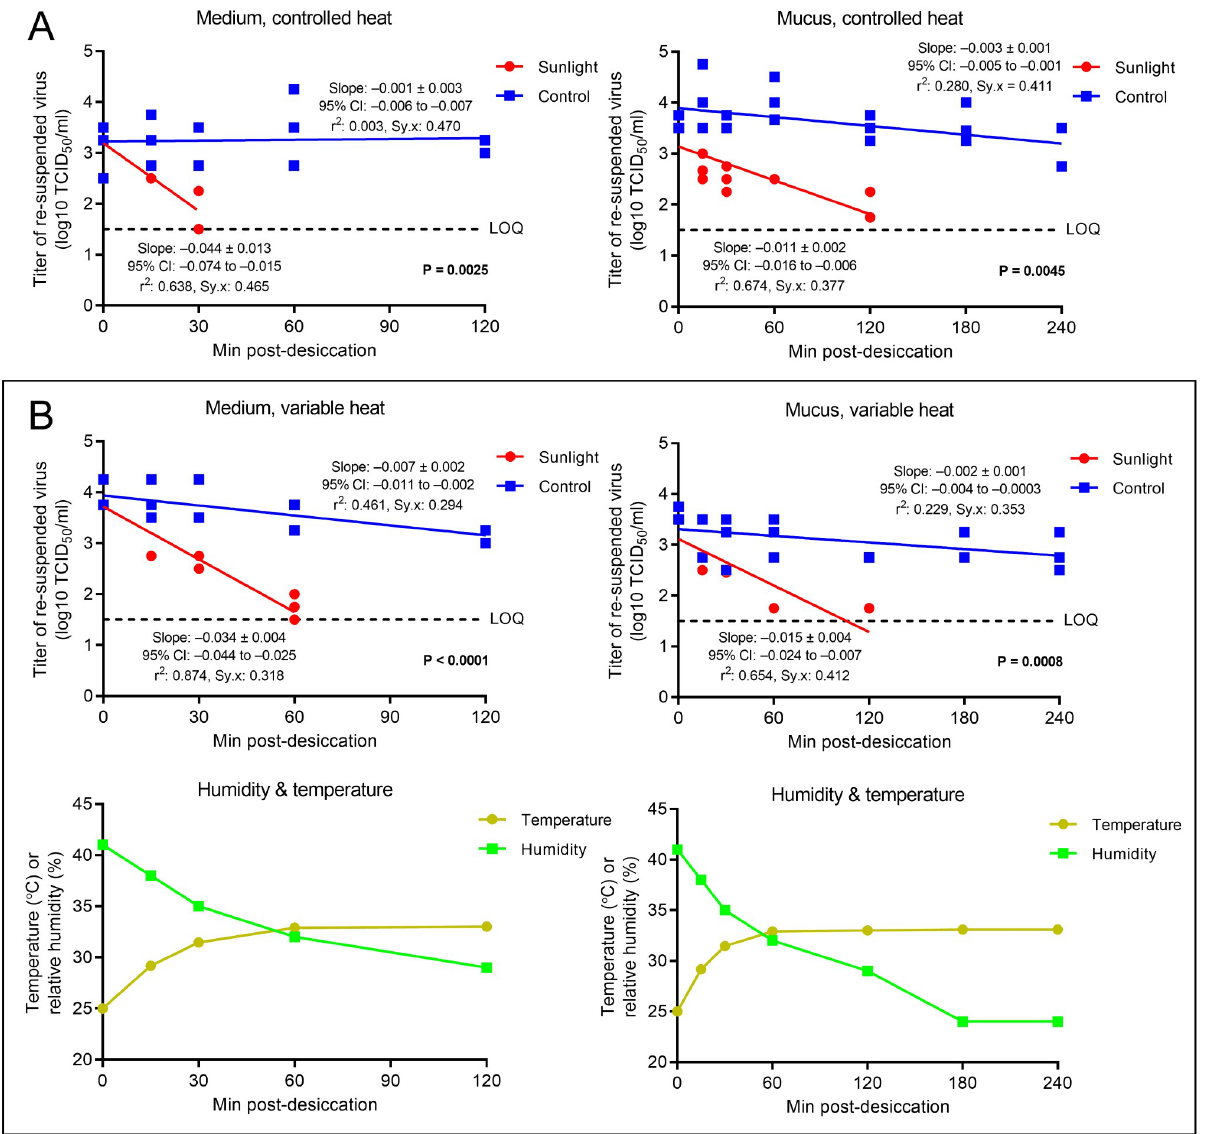
Fig 1. Viability of SARS-CoV-2 on stainless steel after exposure to simulated sunlight. SARS-CoV-2 was suspended in (A) culture medium or (B) an organic matrix, deposited on stainless steel, desiccated, and exposed to either simulated sunlight (“Sunlight”) or corresponding ambient conditions (“Control”). Graphs in (A) and the top row of (B) show linear regression fits for the titer of viable eluted virus, expressed as the log 10 50% tissue culture infectious dose per milliliter (TCID 50 /mL), following culture in Vero cells. The limit of quantitation (LOQ), denoted by a dashed line, is 1.5 logs or 3.16 x 10 1 TCID 50 /mL. Plots show 3 biological replicates per time-point, with each biological replicate representing the average of 3 technical replicates. Viability values falling below the limit of quantitation were not quantifiable and therefore excluded from analysis. Graphs in (A) represent heat- controlled experiments where coupon temperature was held constant at 22.5˚C (relative humidity was 34%). Graphs in the bottom row of (B) show coupon temperature and relative humidity readings measured at each time-point during heat-permitted assays, and correspond to the experiment represented in the graph located directly above. The viability of SARS-CoV-2 observed after sunlight exposure was observed to be significantly lower than that measured in control experiments under all conditions (p � 0.0045). The slope of the regression line for control virus diluted in medium under heat-controlled conditions was not significantly different from zero (p = 0.849). The slope, 95% CI, and goodness of fit parameters, r 2 (coefficient of determination) and Sy.x (SE of estimate), for each regression line are shown above and below the best-fit curves representing the control and experimental conditions, respectively. Raw data and the results of additional statistical analyses are shown in S1–S4 Tables. All graphs were created and statistical analyses performed using GraphPad Prism software (GraphPad Software, www.graphpad.com).